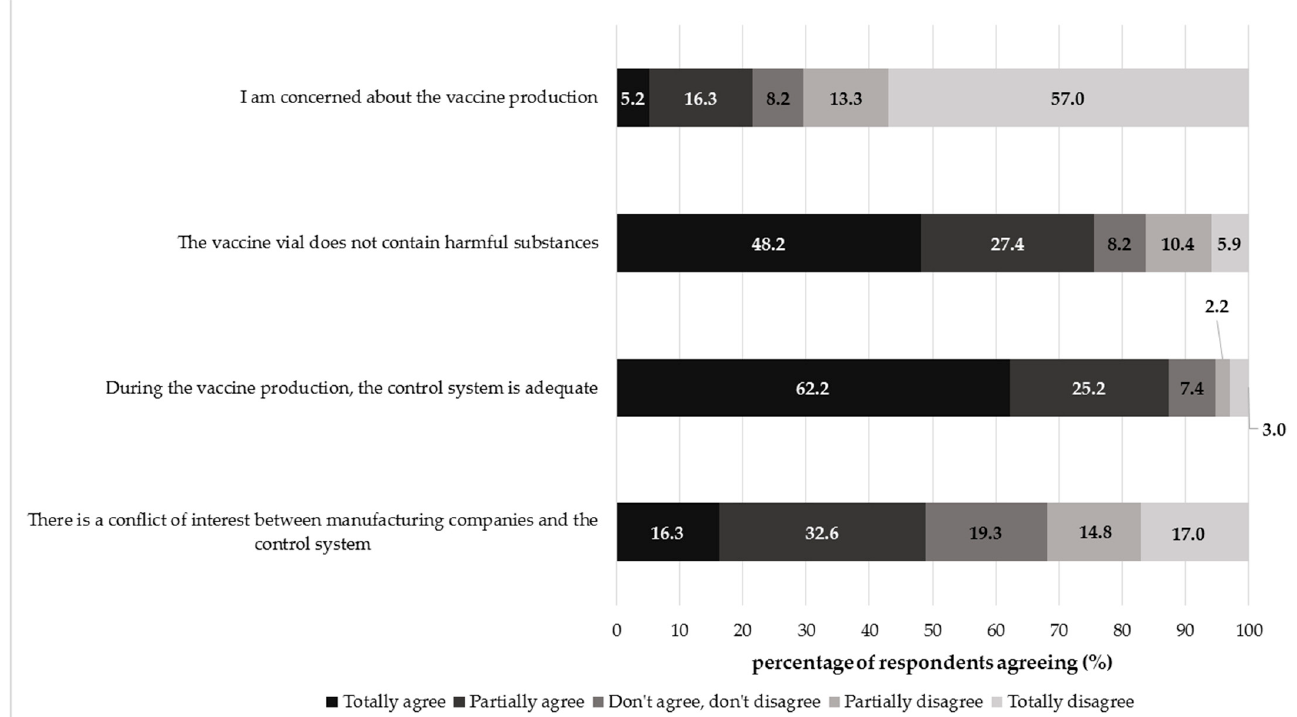
Figure 1. Overall percentage distribution of respondents agreeing regarding the vaccine production process. Cronbach’s alpha coefficient = 0.411.